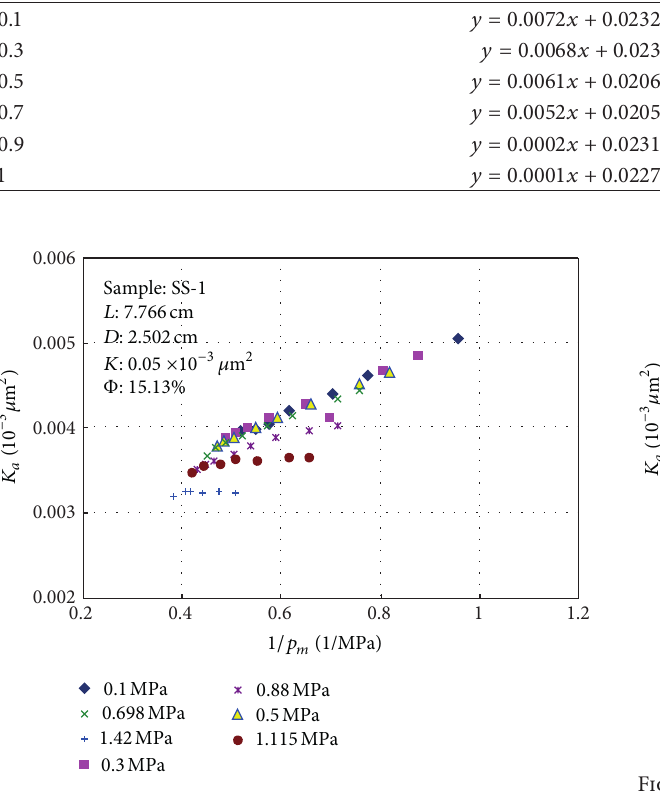
Figure 5: Relationships between 1/𝑝 𝑚 and 𝐾 𝑎 at various backpres- sures for sample SS-1.